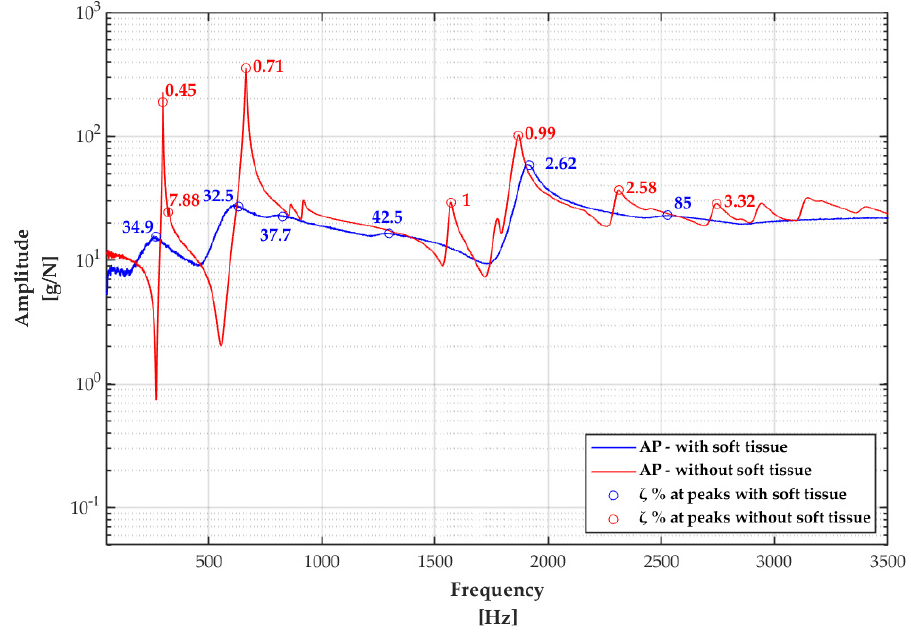
Figure 10. Influence of soft tissue on FRF and damping factors at most prominent peaks for the AP measurements.